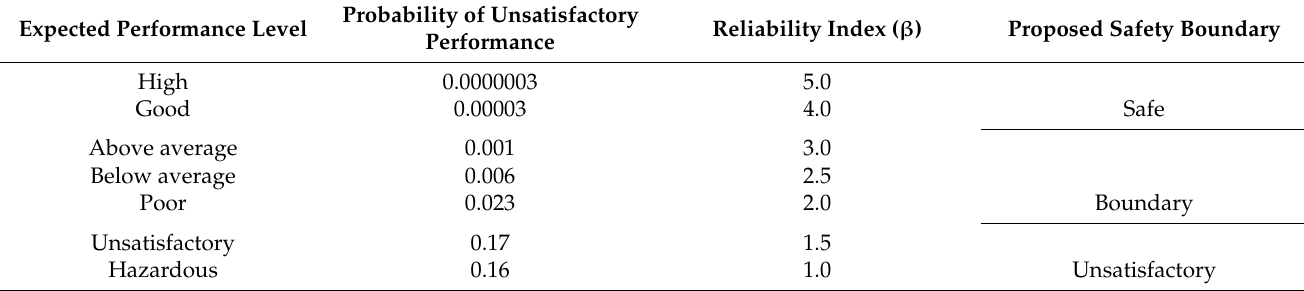
Table 5. The performance chart with the unsatisfactory events and reliability index ranges are modified after [29]. The color represents the proposed subsurface structural safety boundary based on